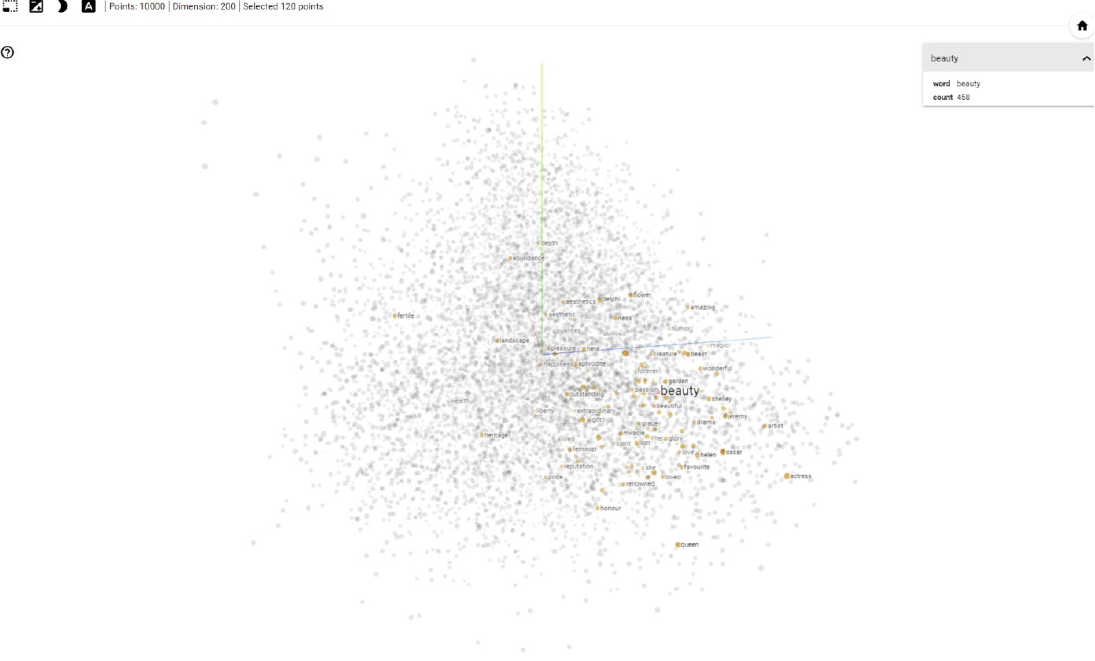
Figure 5. Three-dimensional embedding of word vectors space with PCA (cosine similarity distance). Available on: https://projector.tensorflow.org/ (accessed: 28 July 2022) (screenshot).